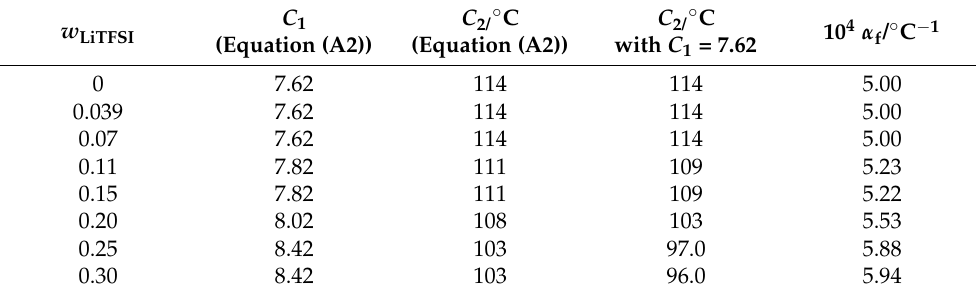
Table A1. C 1 and C 2 values calculated from Equation (A2), C 2 values determined by fitting with fixed C 1 (=7.62), and thermal expansion factor α f for free volume calculated from Equation